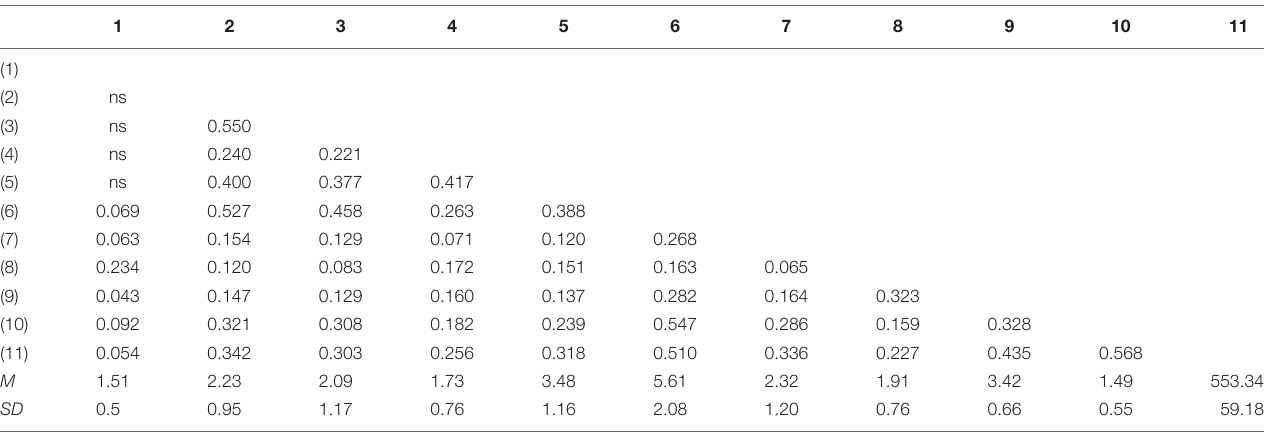
TABLE 2 | Correlations and descriptive statistics of all